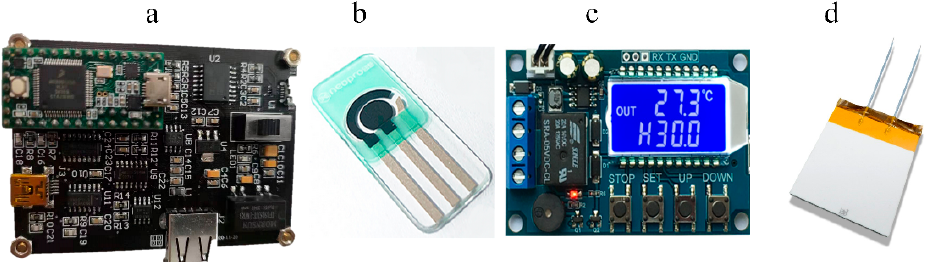
Figure 2. Experimental instruments. Homemade potentiostat ( a ), screen-printed electrode ( b ), homemade thermostat ( c ), ceramic heating plate ( d ).